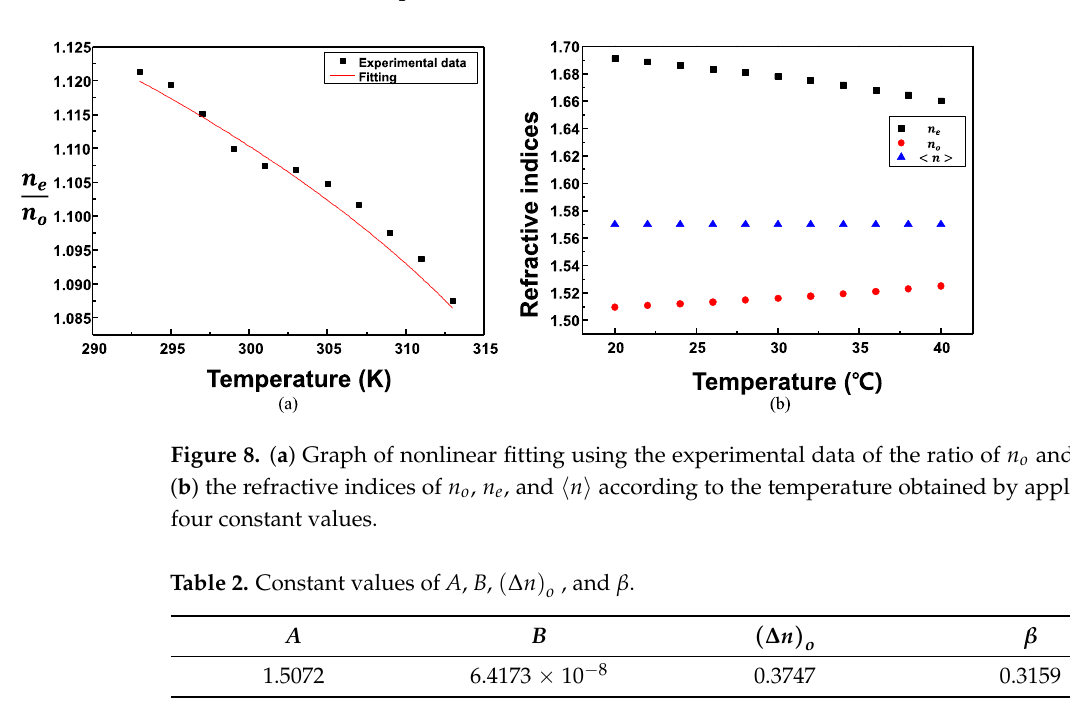
Table 2. Constant values of A , B , (cid:9)Δ(cid:5)(cid:11)